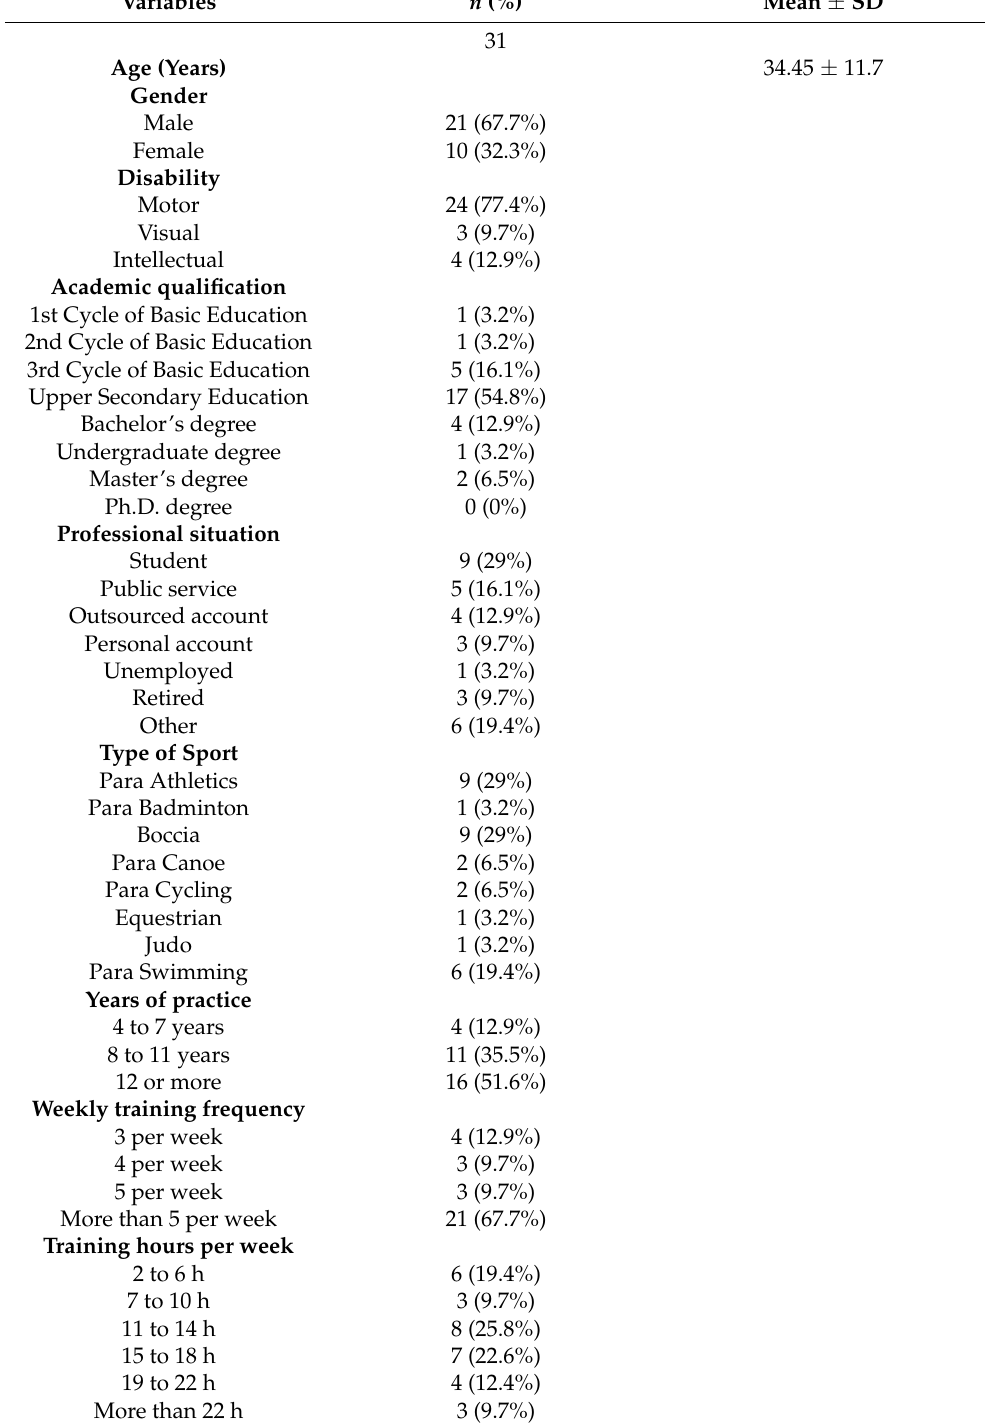
Table 1. Summary of the descriptive statistics for the sample’s sociodemographic characteristics ( n =